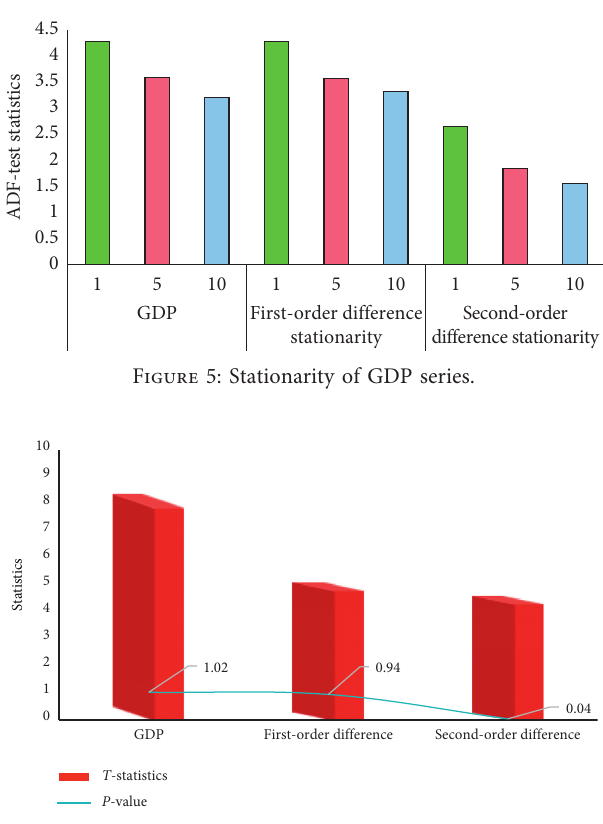
Figure 6: T -test of GDP